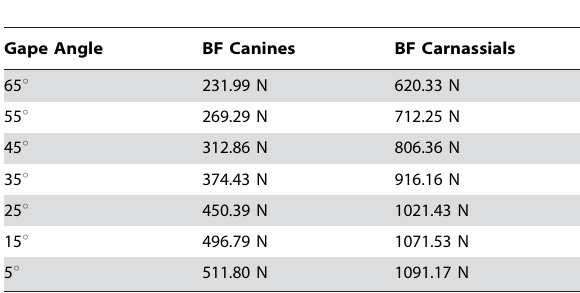
Table 1. Comparison of gape angle and bite point on overall bite force in C. l.